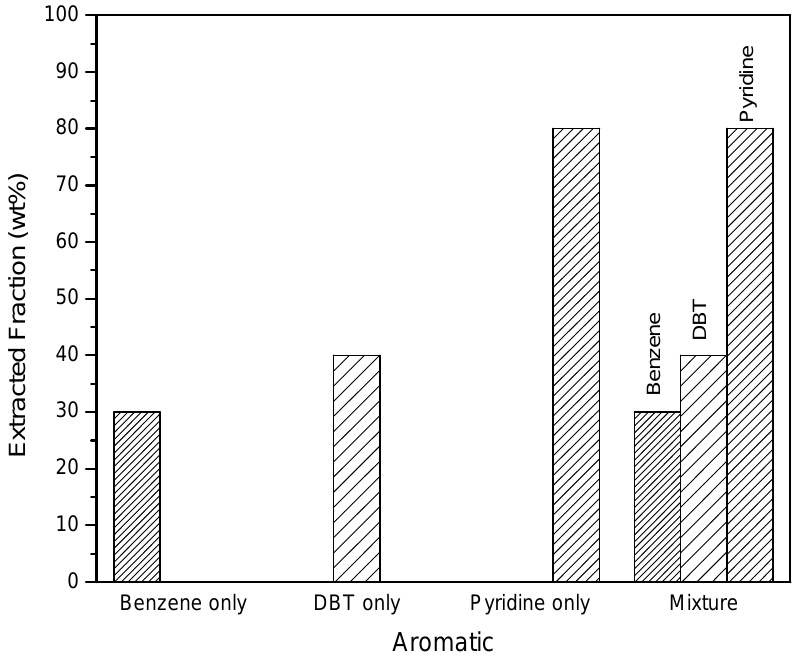
Figure 8. Extraction of benzene (10 wt %), dibenzothiophene (1 wt %) and pyridine (1 wt %) from n -octane (a) in separated solutions and (b) in a solution containing all three contaminants by , (IL:benzene= 1:1 mol/mol, DBT:IL = 1:10 mol/mol, pyridine:IL = 1:10 mol/mol; using BMI.N(Tf) 2 1 ml of